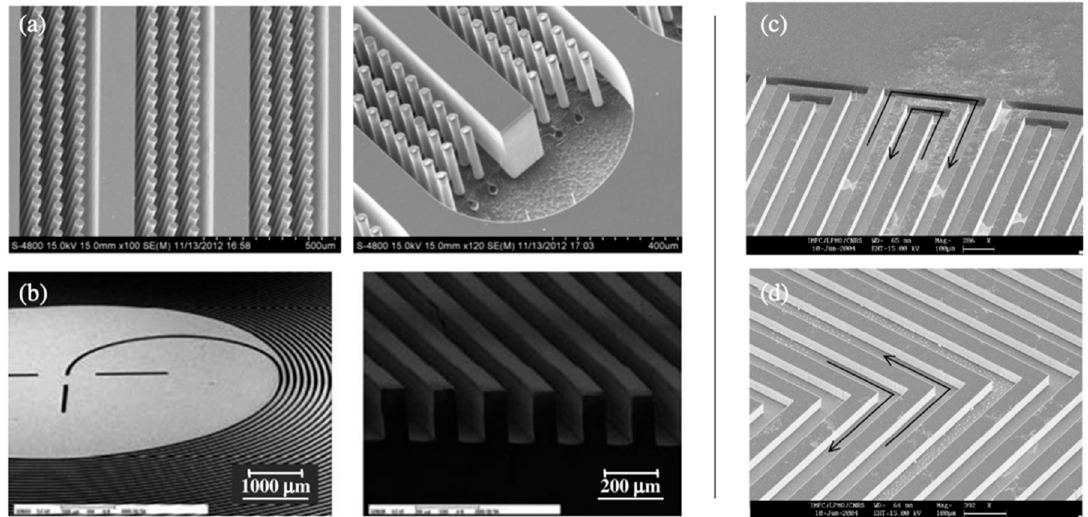
Figure 9. SEM images of different microchromatographic columns layouts on a chip-based configuration: ( a ) semipacked column with embedded microposts, ( b ) circular spiral, ( c ) square spiral, and ( d ) radiator. Reprinted with permission from ref. [234] ( a ), ref. [230] ( b ), and ref. [244] ( c , d ). Copyright 2013 Elsevier (part a), Copyright 2009 IEEJ (part b) and Copyright 2006 Elsevier (part c, d).